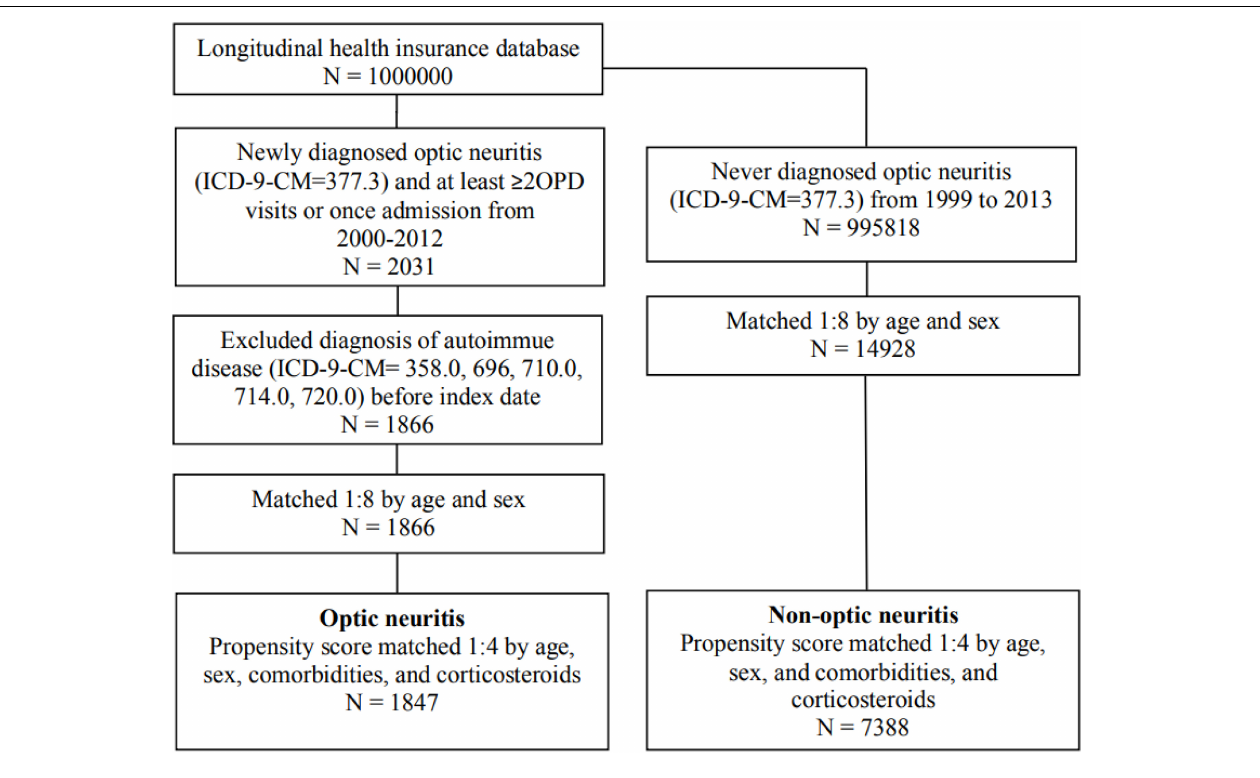
FIGURE 1 | Flowchart of the study design.